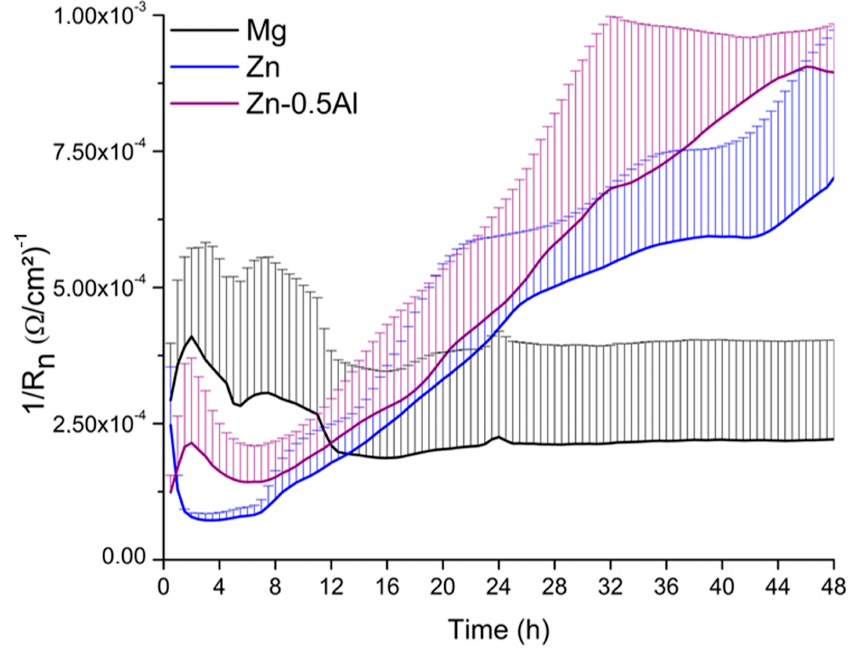
Figure 6. Electrochemical noise (EN)results presented as 1/R n vs. time for pure Mg, pure Zn, and the Zn – 0.5Al alloy over a period of 48 h.